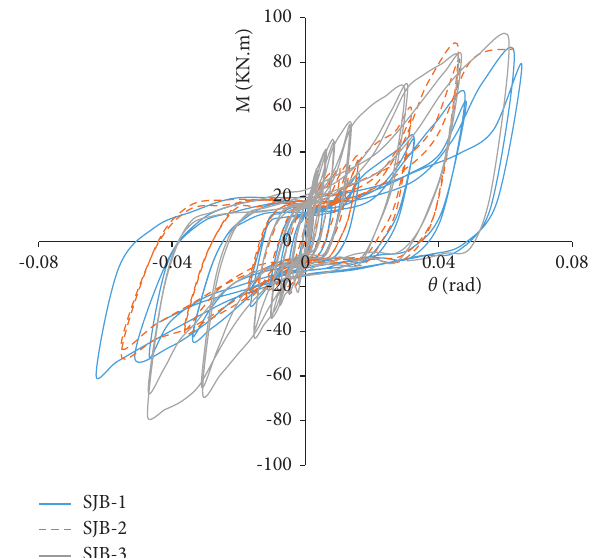
Figure 8: Moment-rotation curves of